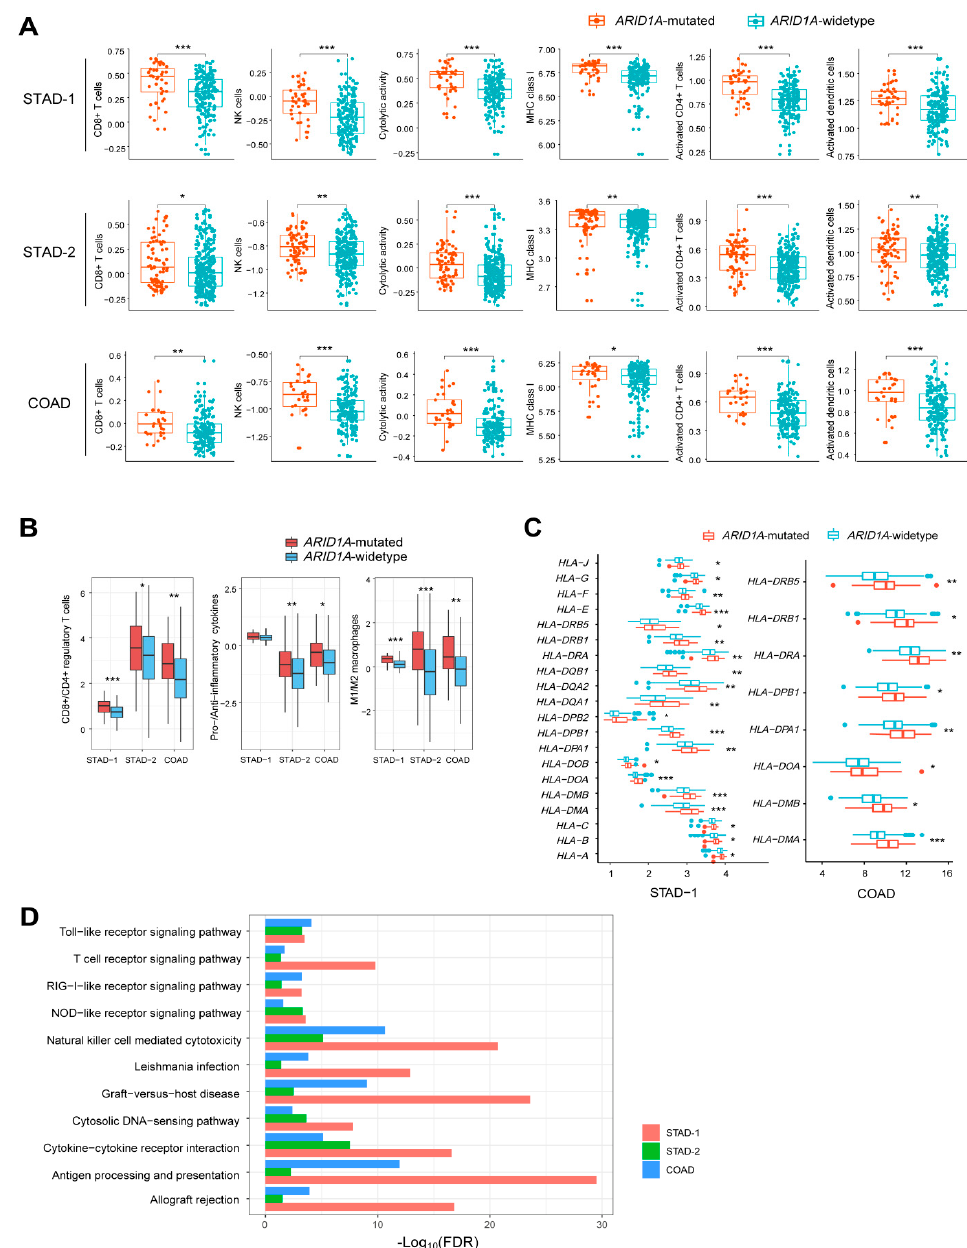
Figure 1. ARID1A -mutated gastrointestinal (GI) cancers have elevated immune activity compared to ARID1A -wildtype GI cancers. ( A ) Diverse immune signatures show significantly higher enrichment levels (ssGSEA scores) in ARID1A -mutated GI cancers than in ARID1A -wildtype GI cancers (Mann-Whitney U test, P < 0.05). ( B ) The ratios between immune-stimulatory signatures and immune-inhibitory signatures are significantly higher in ARID1A -mutated GI cancers than in ARID1A -wildtype GI cancers (Mann-Whitney U test P < 0.05). ( C ) A number of human leukocyte antigen (HLA) genes are more highly expressed in ARID1A -mutated GI cancers than in ARID1A -wildtype GI cancers (Student’s t test, P < 0.05). ( D ) GSEA [27] identifies numerous immune-related KEGG [28] pathways which are more highly enriched in ARID1A -mutated GI cancers than in ARID1A -wildtype GI cancers. FDR: false discovery rate. * P < 0.05, ** P < 0.01, *** P < 0.001. STAD-1: The gastric cancer genomics dataset from the Asian Cancer Research Group (ACRG) [24]. STAD-2: The gastric cancer genomics dataset from The Cancer Genome Atlas (TCGA) [25]. COAD: The colon cancer genomics dataset from TCGA [26]. They also apply to following